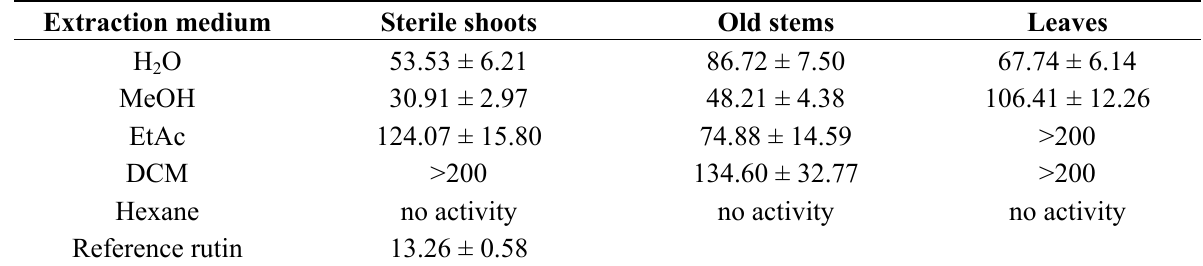
Table 2. Results of the DPPH radical scavenging assay. Results are given as IC